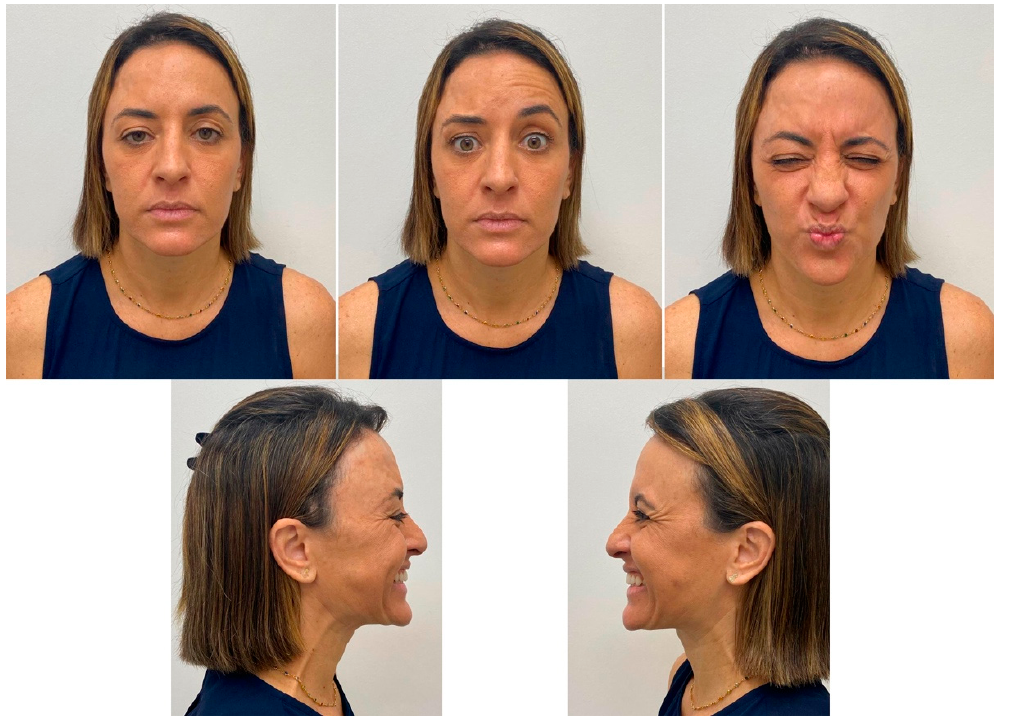
Figure 8. Re-evaluation of the patient after more than 6 months. Observe the difference of the muscle’s activity.